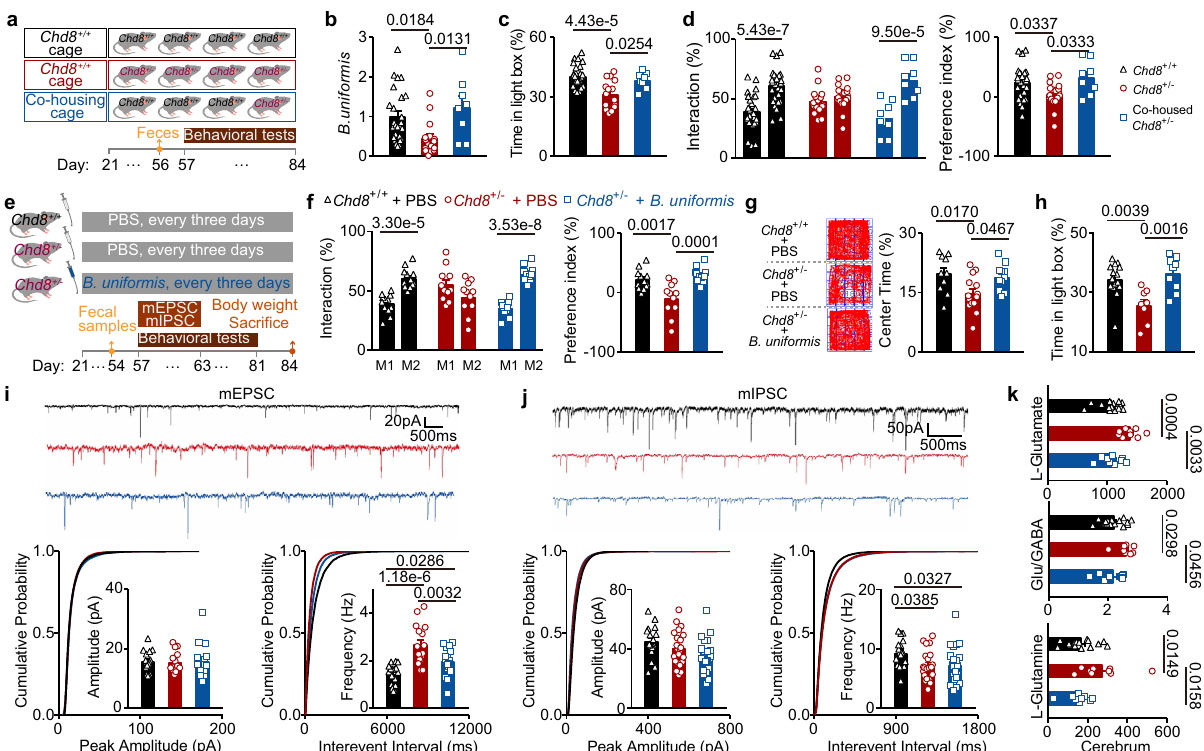
Fig. 4 B. uniformis improves the ASD-like behaviors and restores E/I imbalance in the Chd8 + / − mice. a Schematic diagram for co-housing experiments. b qPCR analysis of B. uniformis in the feces from 8-week-old mice. n = 26, 16, and 8 mice, respectively. c Percentages of time spent in the light box in the light/dark box test. n = 27, 15, and 8 mice, respectively. d Percentages of the interaction time (left) and the preference index (right) in the social novelty preference session of the three-chamber social interaction test. n = 26, 18, and 8 mice, respectively. e Schematic diagram for B. uniformis gavage. f Percentages of the interaction time (left) and the preference index (right) in the social novelty preference session of the three-chamber social interaction test. n = 12, 11, and 11 mice, respectively. g Representative traces (left) and percentages of time in the center (right) in the open- fi eld test. n = 10, 14, and 11 mice, respectively. h Percentages of time spent in the light box in the light/dark box test. n = 15, 8, and 9 mice, respectively. i , j Representative traces (top), cumulative distribution plots (bottom) and bar graphs (bottom) showing the amplitude and frequency of the mEPSCs ( e ) and the mIPSCs ( f ) of pyramidal cells in neocortical layer V. n = 4, 4, and 5 mice, respectively. Four to six data points per mouse. For mEPSCs, n = 17, 16, and 20 data points, respectively; for mIPSCs, n = 18, 22, and 25 data points, respectively. k Levels of L-glutamate ( μ g/g), glutamate/GABA (Glu/GABA), and L-glutamine ( μ g/g) in the cerebrum detected by targeted metabolomics assays. n = 16, 9, and 9 mice, respectively. Quantitative data are shown as the mean ± SEM. Statistical analysis was determined by one-way ANOVA with two-tailed Tukey ’ s multiple comparison test ( b , c , d (right panel), f (right panel), g , h , i , j , k ) and two- way ANOVA with two-tailed Turkey ’ s test for multiple comparisons ( d (left panel) and f (left panel)). Signi fi cance was indicated by P value.